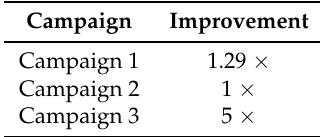
Table 3. Hit-rate (estimated accuracy) results.